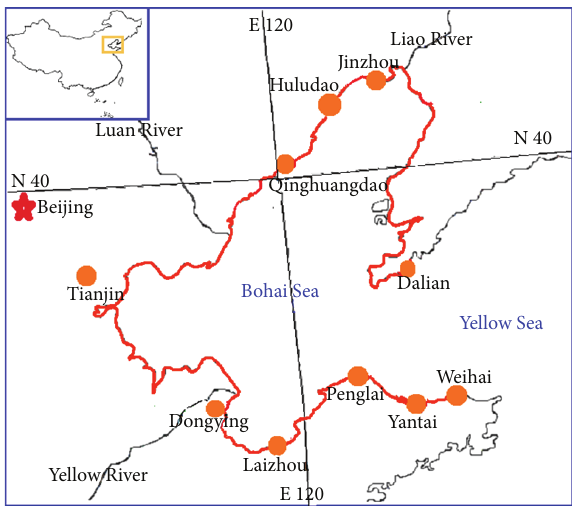
Figure 1: Main cities and rivers around Bohai